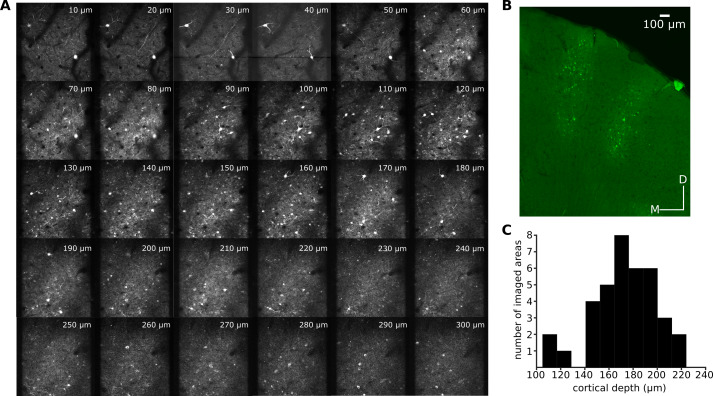
Imaging in layer 2/3 of ferret A1.(A) A series of z-projections acquired in vivo using two-photon imaging in ferret 7. The projections have the same fronto-caudal and dorso-ventral axis as the imaged field shown in Figure 1A. Projections were selected to show 10 µm increments in cortical depth. While imaging, the most superficial neuronal bodies were visible ~ 60 μm below the cortical surface. (B) A coronal section of the A1 of ferret 4 showing the extent of GCaMP6 labeling throughout the cortical depth. (C) Distribution of the number of fields imaged at each cortical depth.